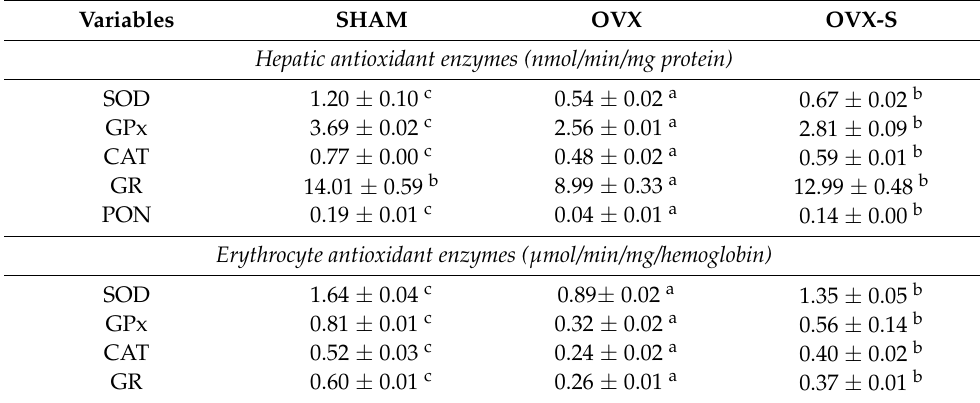
Table 5. Changes in hepatic and erythrocyte antioxidant enzyme activities of Superjami rice bran extract supplement diet in ovariectomized